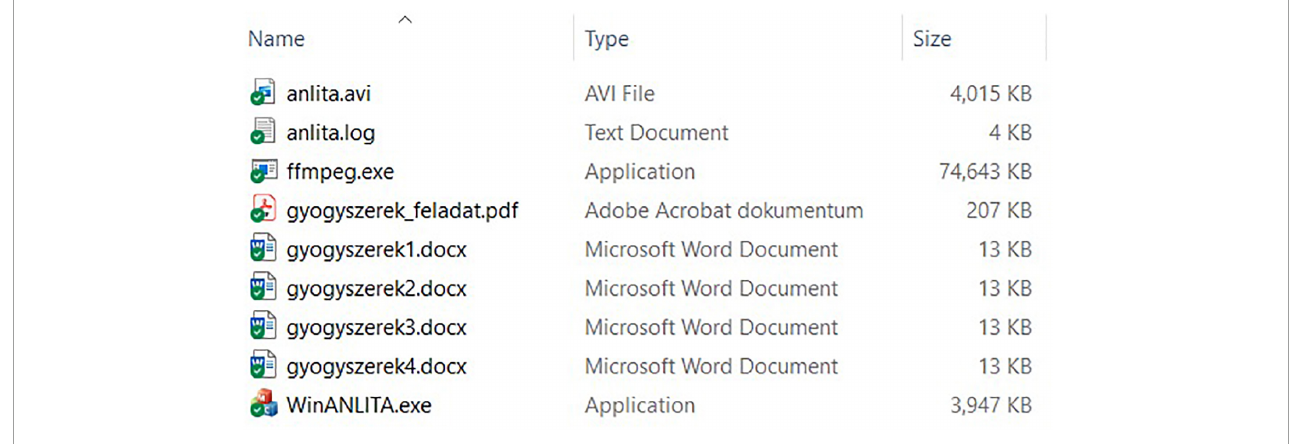
FIGURE8 Contents of the finished test folder to be